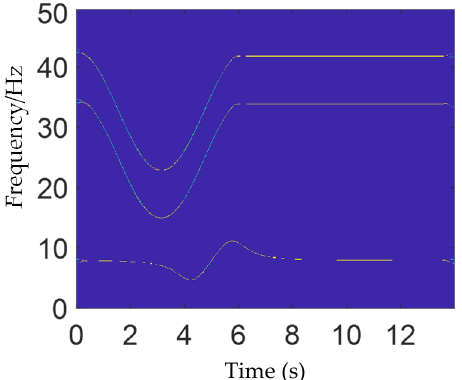
Figure 4. TF distribution of the simulated signal based on RSECT.